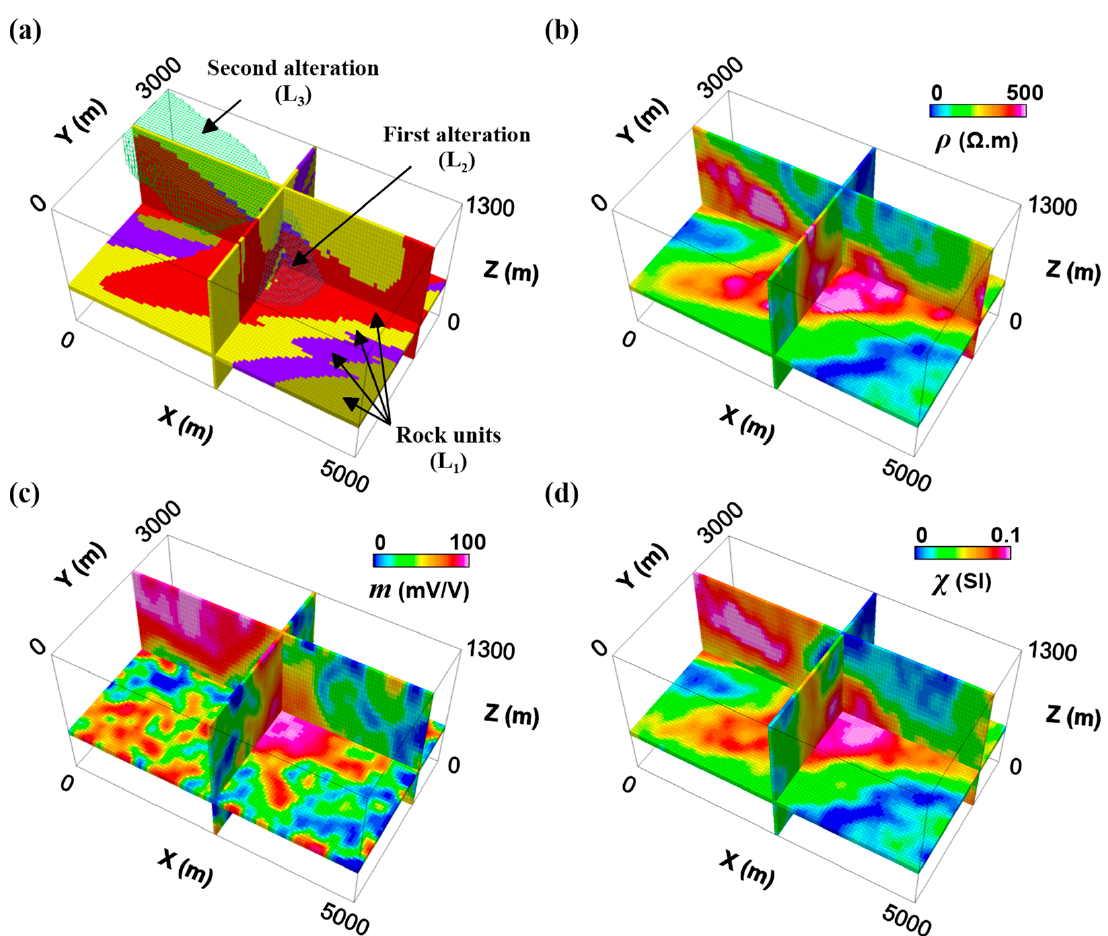
Figure 5. The mixing system produces three overlapped physical properties ( ρ , m and χ in b – d ) from simulated geological features ( a ). Each physical property distribution shows a portion of the whole geological features ( b – d ). The source separation aims to recover the hidden independent features to reconstruct the whole geological model.